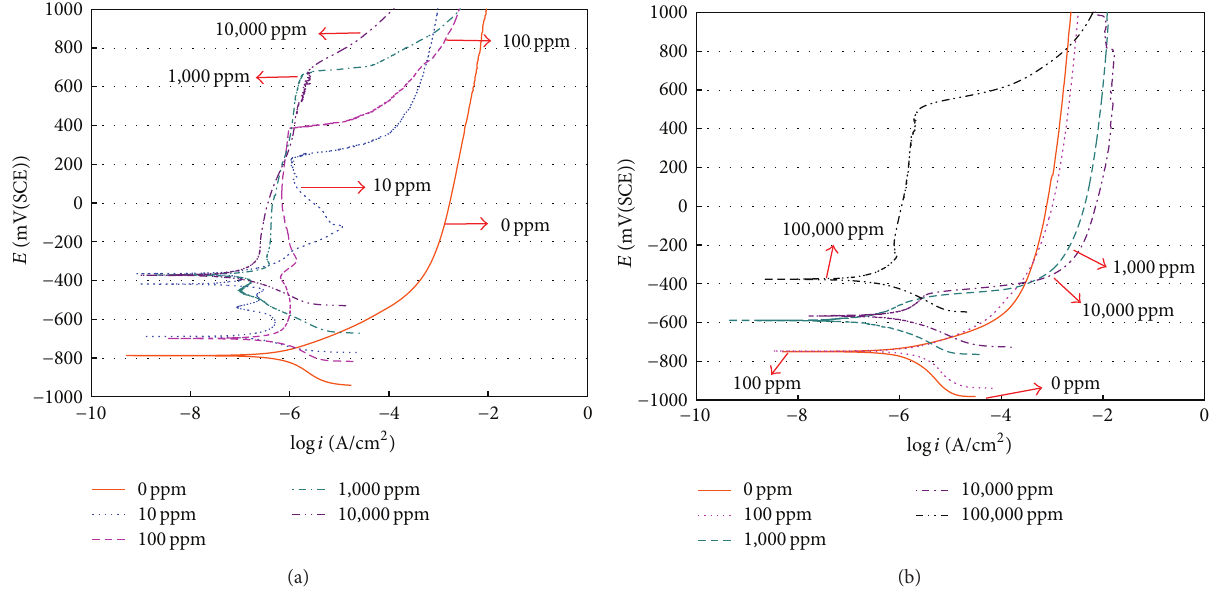
Figure 3: Effect of NaNO 2 addition on polarization behavior in deaerated simulated cooling water at 25 ∘ C (scanning rate; 0.33 mV/s); (a) carbon steel and (b) ductile cast